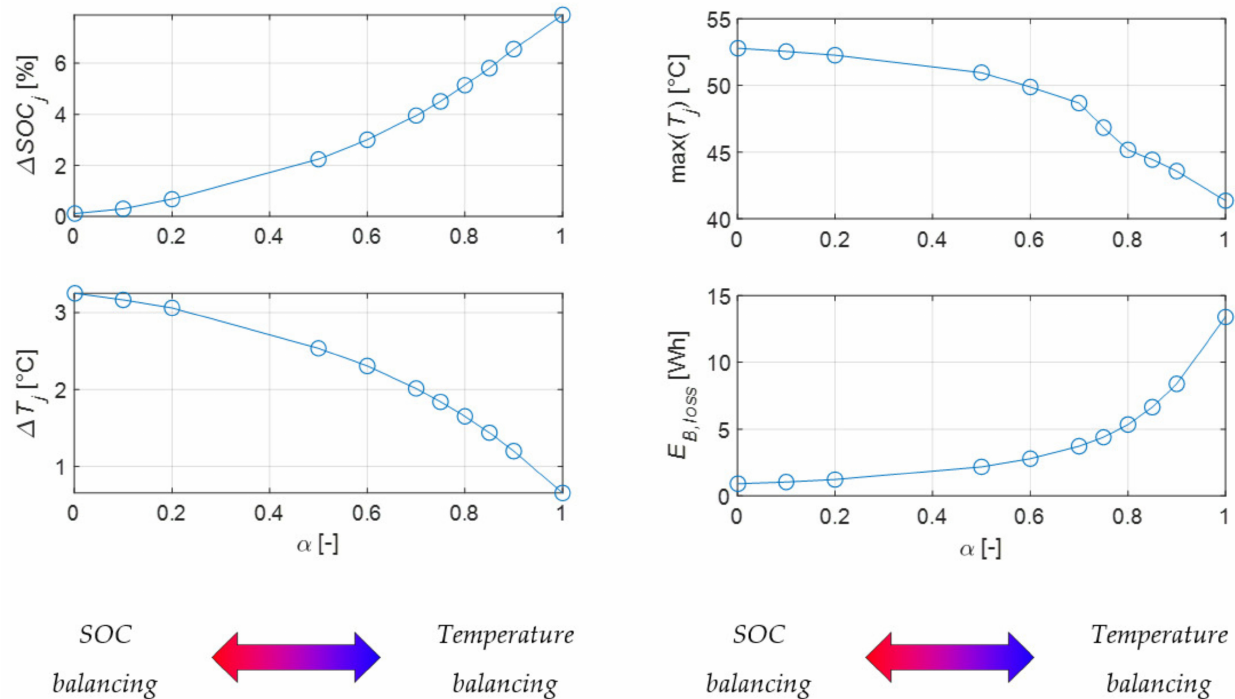
Figure 16. Sensitivity analysis: dual balancing (SOC and temperature): σ 1 = 2000 ( 1 − α ) , σ 2 = 20 α , σ 3 = 0. End condition: (cid:16) (cid:17) ≤ 0.5. Scenario: aggressive driving (US06), mixed aging, parallel forced air cooling ( h = 15 W/m 2 K). min SOC j